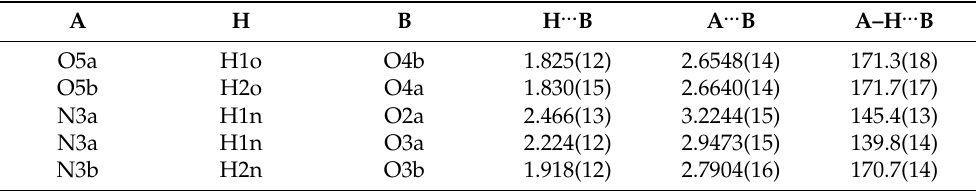
Figure 3. The four-molecule aggregate in 1 features hydroxyl-O–H ... O(oxido) and charge-assisted N–H ... O3 hydrogen bonds shown as orange and blue dashed lines, respectively. Table 2. Geometric parameters (Å, ◦ ) characterizing the identified hydrogen bonding contacts between the constituents of the asymmetric unit of salt 1 leading to a four-molecule